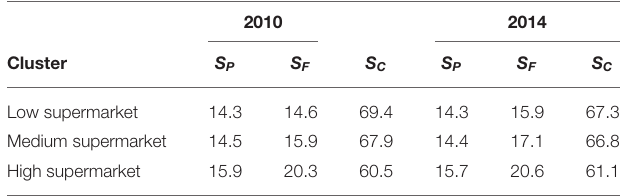
TABLE 2 | Evolution of macronutrient shares by supermarket clusters and over years.